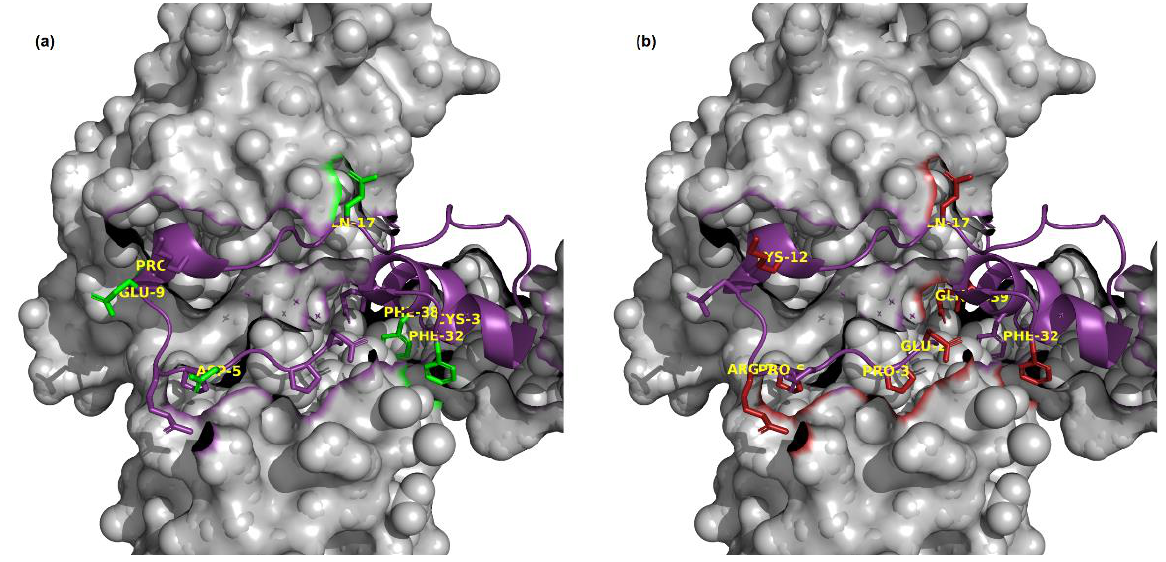
Figure 6. The structure (PDB ID: 4OR5) of the Tat: Cyclin T1 complex. Tat (purple cartoon) binds to Cyclin T1 (surface view). ( a ) Underestimated variants are colored green. ( b ) Overestimated variants are colored red.